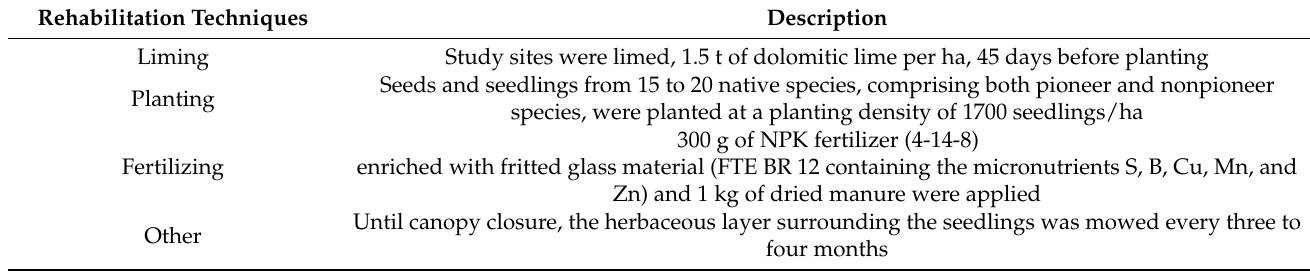
Table 1. Summary of the rehabilitation techniques employed in the three rehabilitation stages.